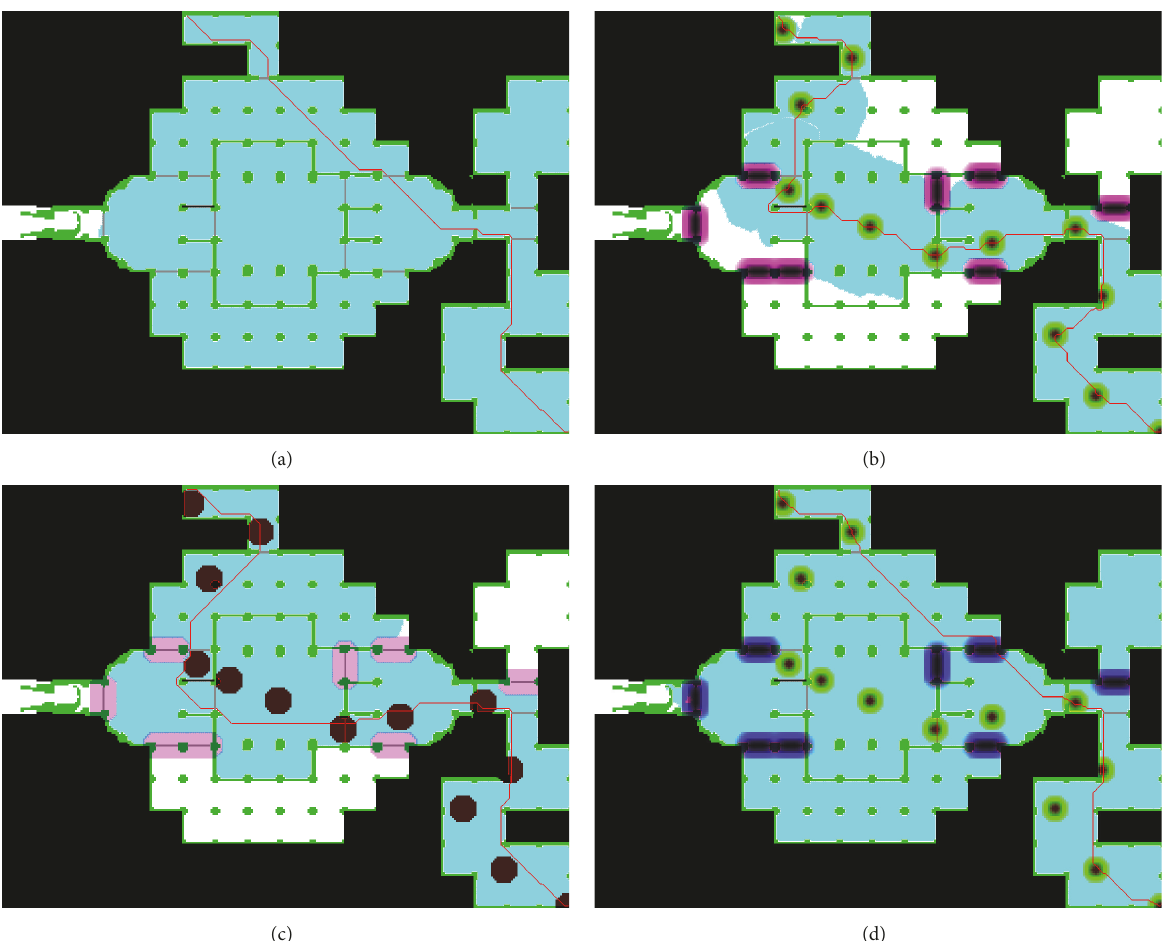
Figure 9: Distinct paths found within the arena2 map of Dragon Age: Origins by (a) Dijkstra’s, (b) DjT, (c) DjRAP, and (d) DjCAN pathfinders. Cyan nodes are neutral nodes covered by the space search. DjT repulsor nodes in (b) kept their original dark lilac-to-light-lilac colors so that they were not visited. Thus, DjT repulsors contain the space search. However, the same repulsor nodes in (d) appear in purple blue because they were visited, that is, their original dark lilac-to-light-lilac colors were combined with cyan. This color blending occurs because DjCAN does not repel enough: that is, DjCAN repulsors do not sustain the space search. Note that the attractor nodes in (b) and (d) appear in dark red-to-green because they were visited, that is, their original red-to-yellow color was blended with cyan. In (c), we see that repulsors (in light lilac) also sustain the expansion of the search space, but repulsor nodes have the same color because their influence values are constant in